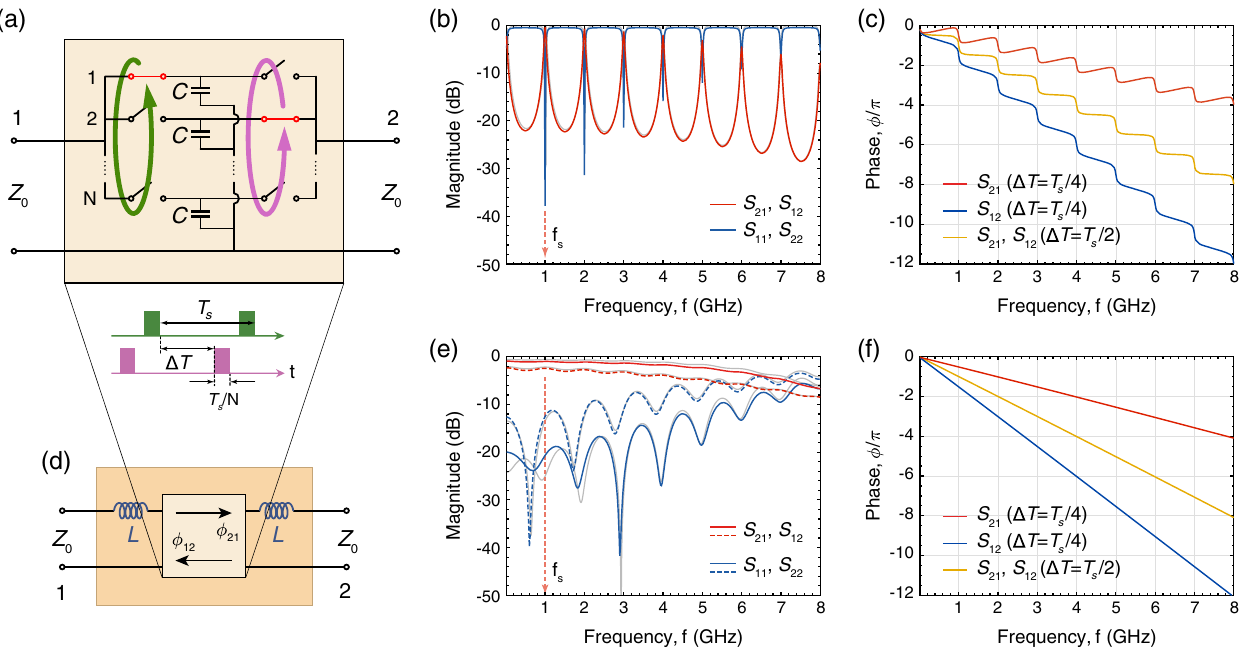
FIG. 1. (a) Schematic of an electronic circuit with N identical paths containing switched shunt capacitances. Each switch is closed over =N , where T the interval T is the switching period, and the input and output set of switches are operated in a revolving fashion. The s s output set lags the input set by time Δ T corresponding to a phase shift γ ¼ − 2 π Δ T=T . (b),(c) Magnitude and phase of the scattering s ¼ 1 GHz, and Z ¼ 50 Ω , leading to τ ≫ T =N (here, τ ¼ Z 0 C ), parameters of the network in (a) with N ¼ 16 , C ¼ 15 pF, f 0 s s = 2 (phase-reciprocal case) and Δ T ¼ T = 4 which allows it to operate as an N -path filter. The phase response is computed for Δ T ¼ T s s (phase-nonreciprocal case). For both cases, the magnitudes of scattering parameters are identical. (d) Schematic of a circuit operating as a wideband phase shifter, comprised of a commutated network with small series inductances on both sides. (e),(f) The same as (b),(c), =N , which allows the network to operate as a wideband phase shifter. Dashed lines and solid but with C ¼ 0 . 68 pF, leading to τ ∼ T s lines show the response with and without small matching inductances L ¼ 0 . 75 nH, respectively. (f) Corresponding phase response. Results in (b), (c), (e), and (f) are obtained by means of the method outlined in the Appendix. The light gray “ shadow ” curves in (b) and (e) indicate simulation results obtained using Cadence Spectre RF (PSS solver)